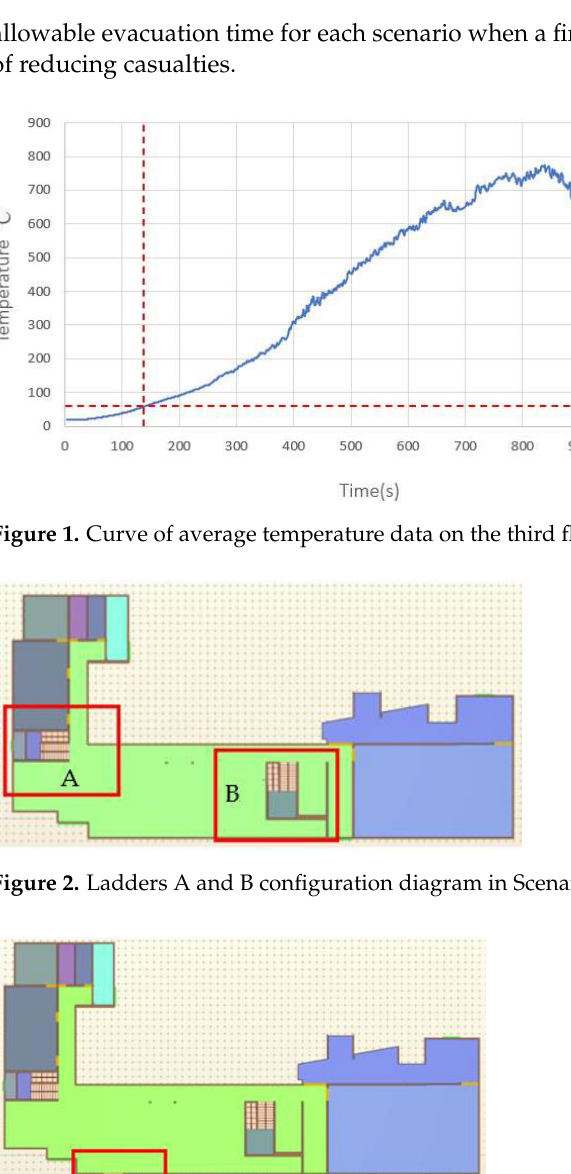
Figure 3. Independent power supply elevator configuration diagram in Scenario B.